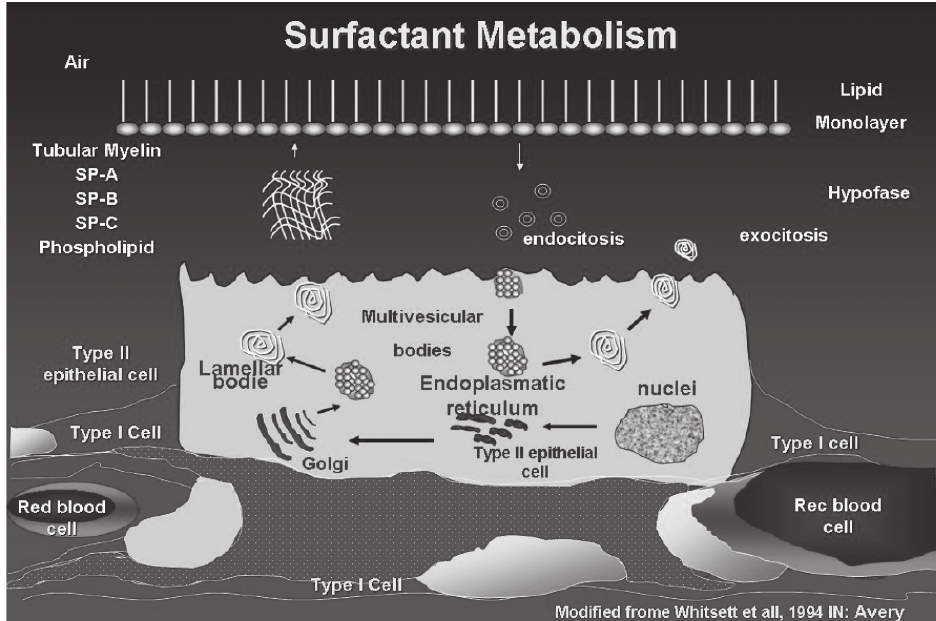
Figure 2 - Surfactant intracellular metabolism. Modified from Whitsett et al